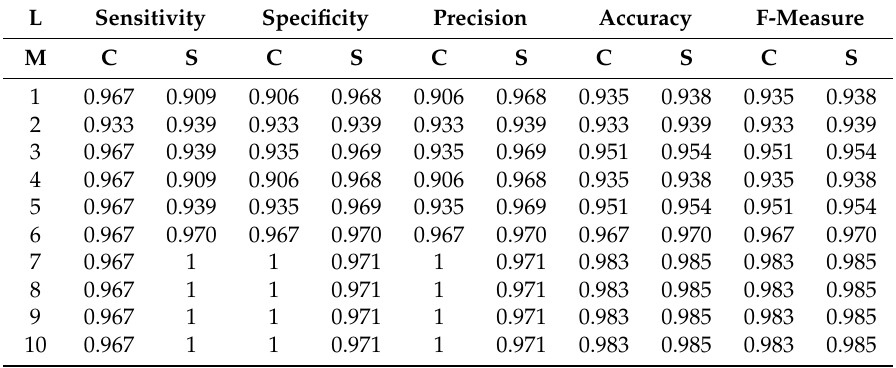
Table 4. Sensitivity, specificity, precision, accuracy and F-measure for the controls (C) and subjects (S) groups. The results w.r.t. the number of modes (M) of both left (L) and right (R) sides are shown.